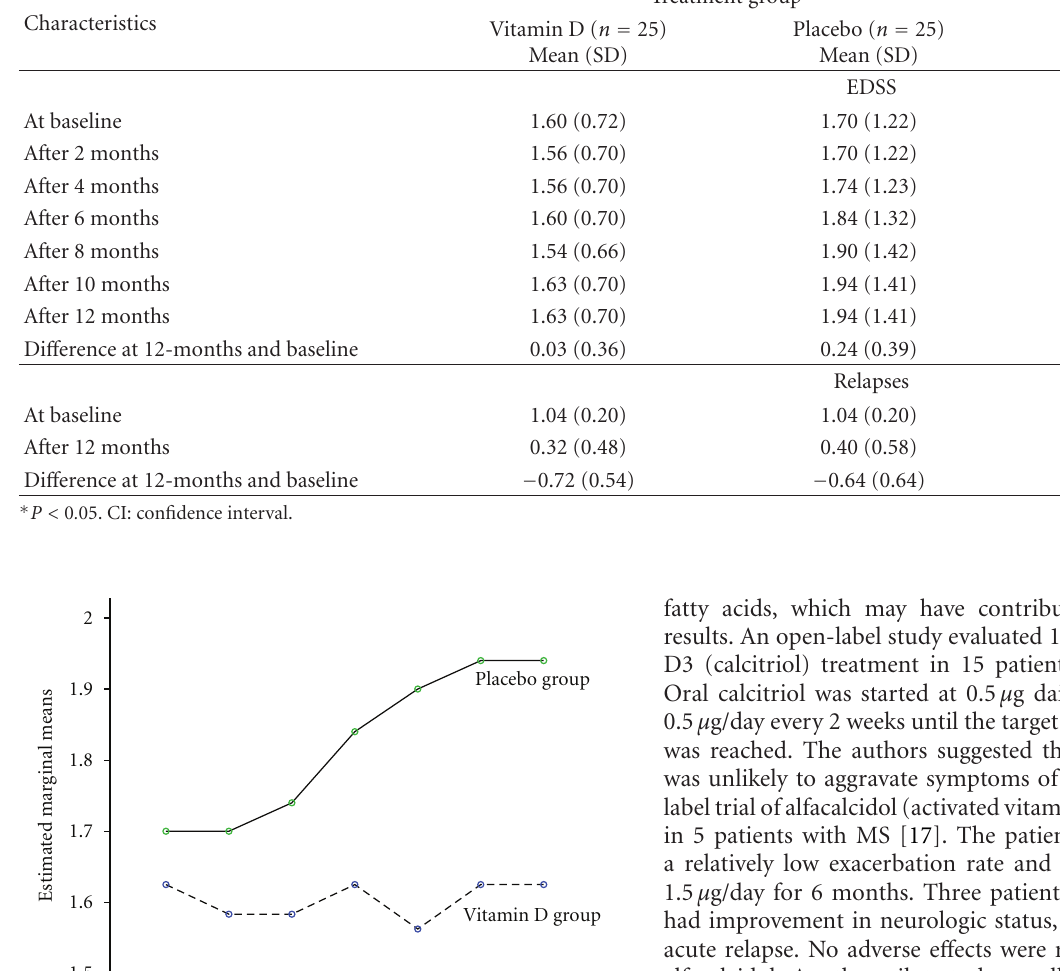
Table 4: Comparison of Expanded Disability Status Scale (EDSS) and relapses in 50 patients with relapsing-remitting multiple sclerosis before and 2, 4, 6, 8, 10, 12 months after treatment with low-dose vitamin D and placebo. Characteristics